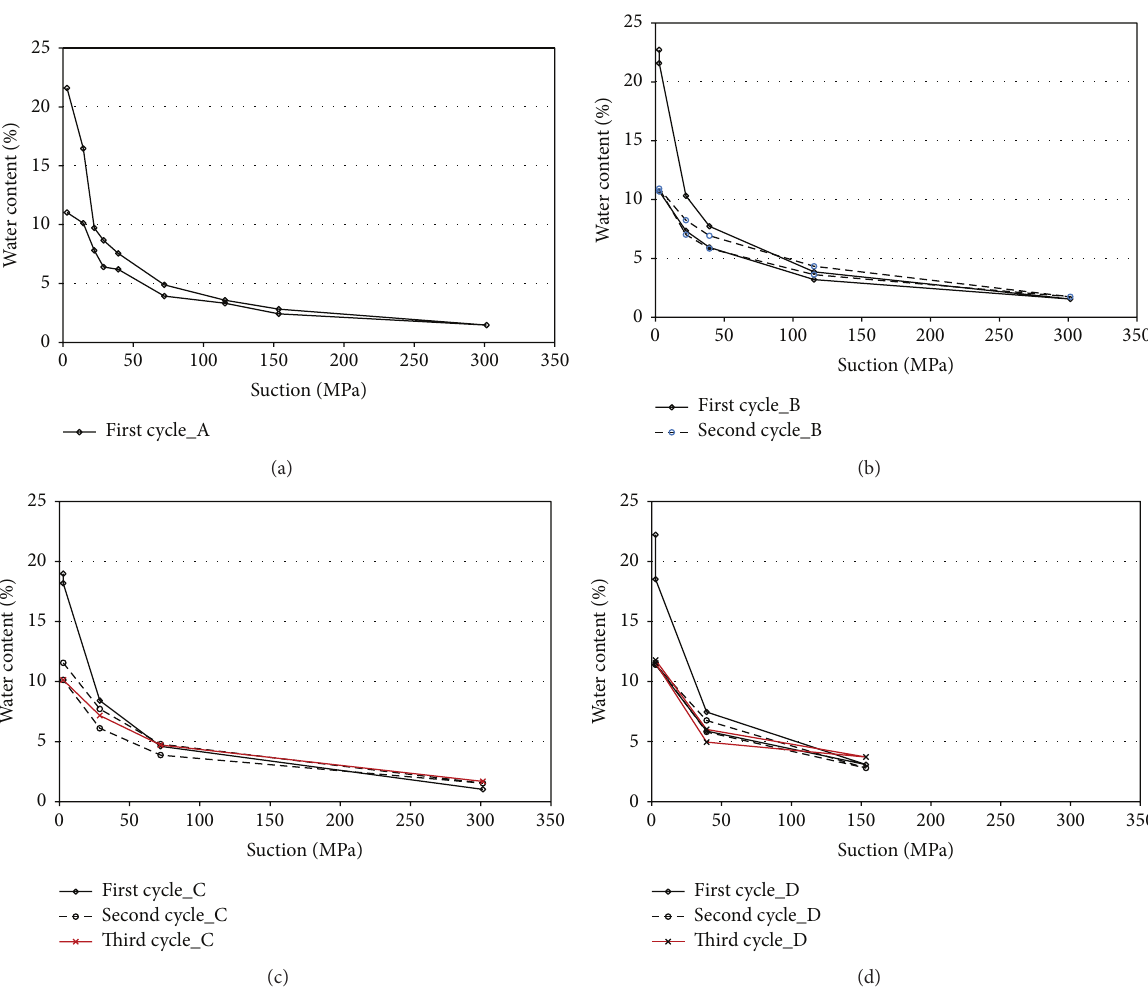
Figure 2: The water retention curves of the samples A1, B1, C1, and